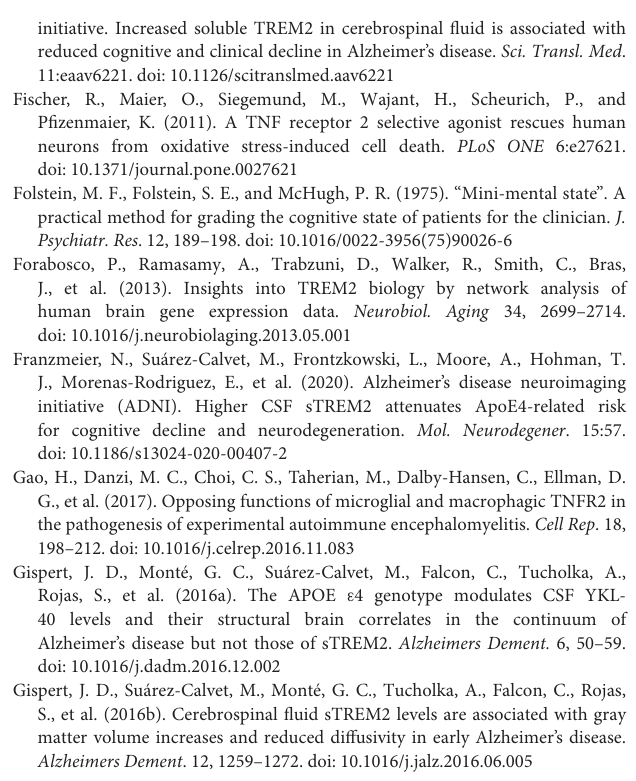
Supplementary Table 8 | Key results of the linear mixed-effects regression model with CDR-SB as the dependent variable among CN A– T + cognitively normal participants from the Alzheimer’s Disease Neuroimaging Initiative cohort (Model 3). Supplementary Table 9 | Key results of the linear mixed-effects regression model with CDR-SB as the dependent variable among A + T– cognitively normal participants from the Alzheimer’s Disease Neuroimaging Initiative cohort (Model 3). Supplementary Table 10 | Key results of the linear mixed-effects regression model with CDR-SB as the dependent variable among A– T– cognitively normal participants from the Alzheimer’s Disease Neuroimaging Initiative cohort (Model 3). Supplementary Table 11 | Demographics of A + T + participants with CSF sTREM2 values (includes those without concomitant sTNFR2 data) along with CSF AD biomarkers in the Alzheimer’s Disease Neuroimaging Initiative cohort for sensitivity analysis. Supplementary Table 12 | Demographics of cognitively normal participants with CSF sTREM2 values (includes those without concomitant sTNFR2 data) along with CSF AD biomarkers in the Alzheimer’s Disease Neuroimaging Initiative cohort for sensitivity analysis. Supplementary Table 13 | Sensitivity analysis of linear mixed-effects regression model with CDR-SB as the dependent variable among participants with A + T + mild cognitive impairment from the Alzheimer’s Disease Neuroimaging Initiative cohort with n = 111 with sTREM data alone. Supplementary Table 14 | Sensitivity analysis of linear mixed-effects regression model with CDR-SB as the dependent variable among participants with A + T + dementia from the Alzheimer’s Disease Neuroimaging Initiative cohort with n = 57 with sTREM data alone. Supplementary Table 15 | Sensitivity analysis of linear mixed-effects regression model with CDR-SB as the dependent variable among participants with A + T + CN from the Alzheimer’s Disease Neuroimaging Initiative cohort with n = 16 with sTREM data alone.